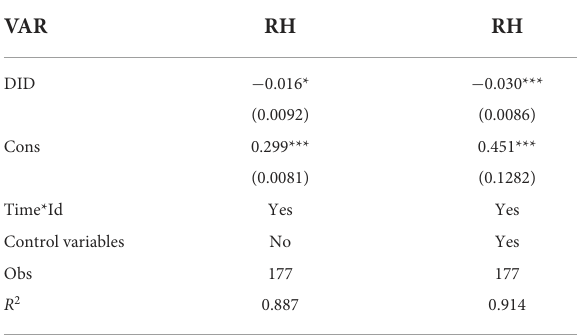
TABLE 5 PSM-DID regression results.